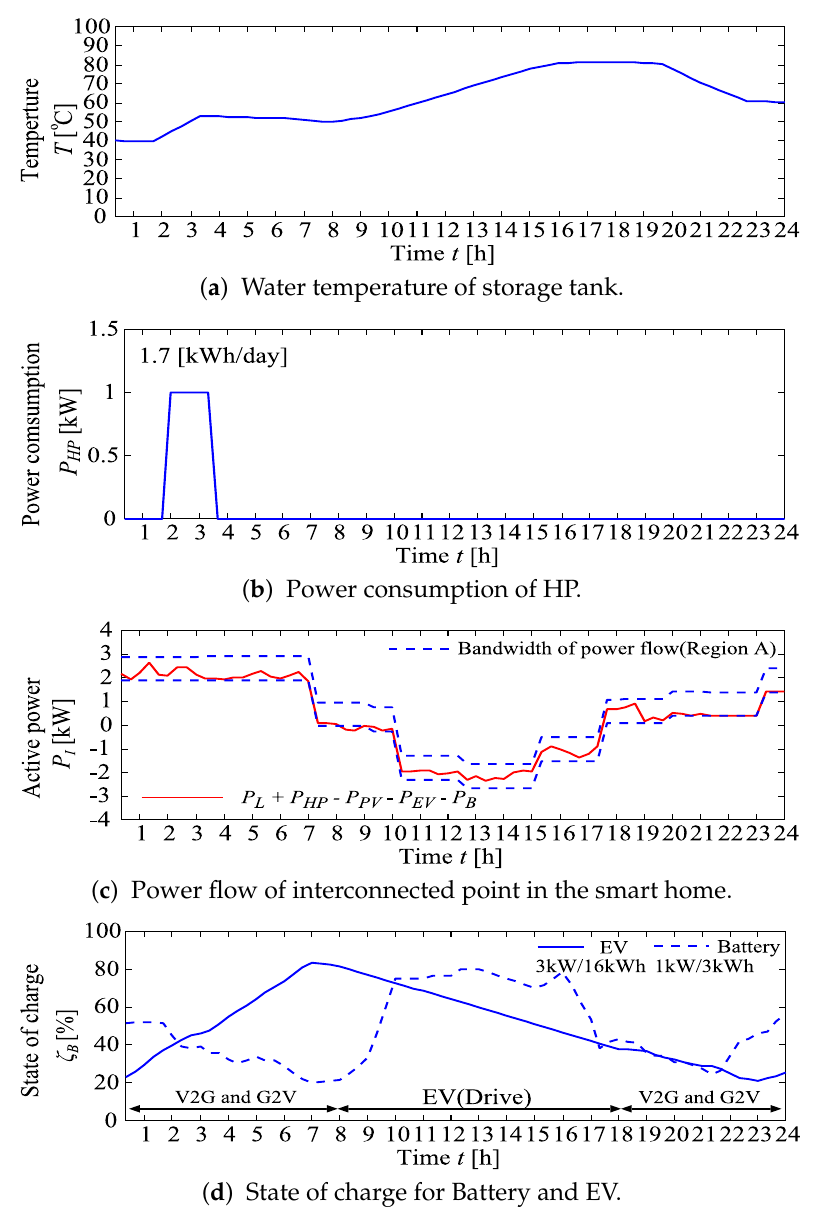
Figure 11. Simulation results with considering re-forecast, re-plan and uncertainties on a fair day (Case